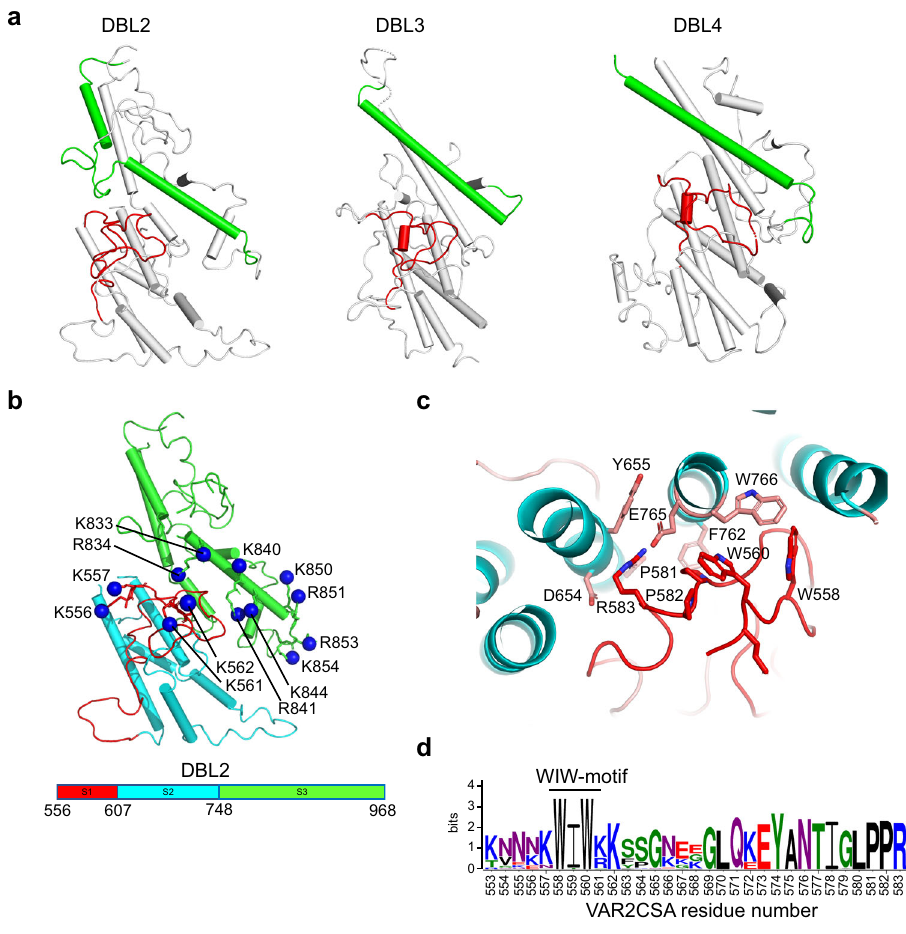
Fig. 2 Structural analysis of DBL2 and CS binding groove. a Comparison of domains DBL2, DBL3 and DBL4. The red loop shows the “ WIW-motif ” -loop from each domain, the green α -helix shows HB1. In DBL2, an additional loop in HB1 introduces a kink in the α -helix. b DBL2 domain shown as cartoon, the red loop shows S1 (HB4 and “ WIW-motif ” -loop), blue α -helices show S2 (HB3-HB5) and green α -helices show S3 (HB2-HB1). S1-S3 residue boundaries and colors are shown in legend below. The distal nitrogen atom of Lys/Arg residues side chains in binding groove are shown as blue spheres and labeled according to residue number. c Structural details of the interaction between “ WIW-motif ” and HB2/HB3 in DBL2. Interacting side chains are shown as sticks and are labeled with residue numbers. d LOGO conservation analyses of “ WIW-motif ” -loop AA553-583 in var2csa variants. Residue number from VAR2CSA sequence shown